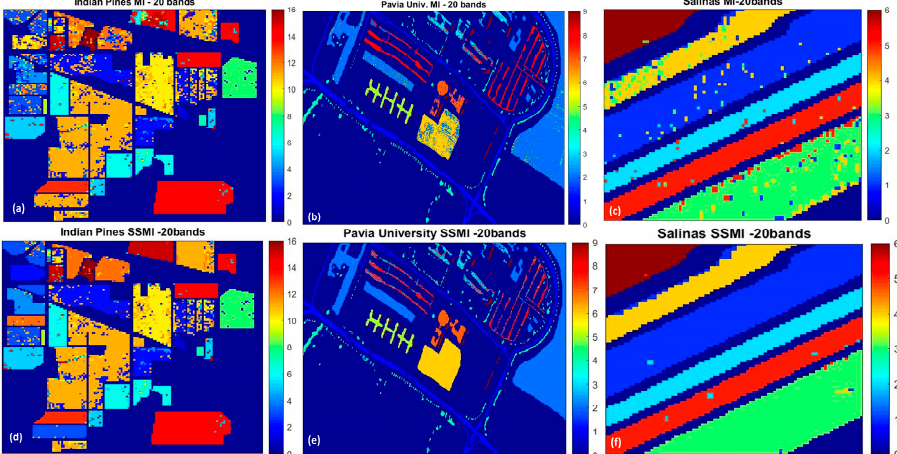
Figure 9. The false color classification maps of three datasets: ( a ) and ( d ): Indian Pines, ( b ) and ( e ): Pavia University, ( c ) and ( f ): Salinas; obtained by SVM classification (10% training) through the MI BS scheme (Upper panel) and the proposed SSMI method (Lower panel), which exhibits a substantial reduction of false alarms.